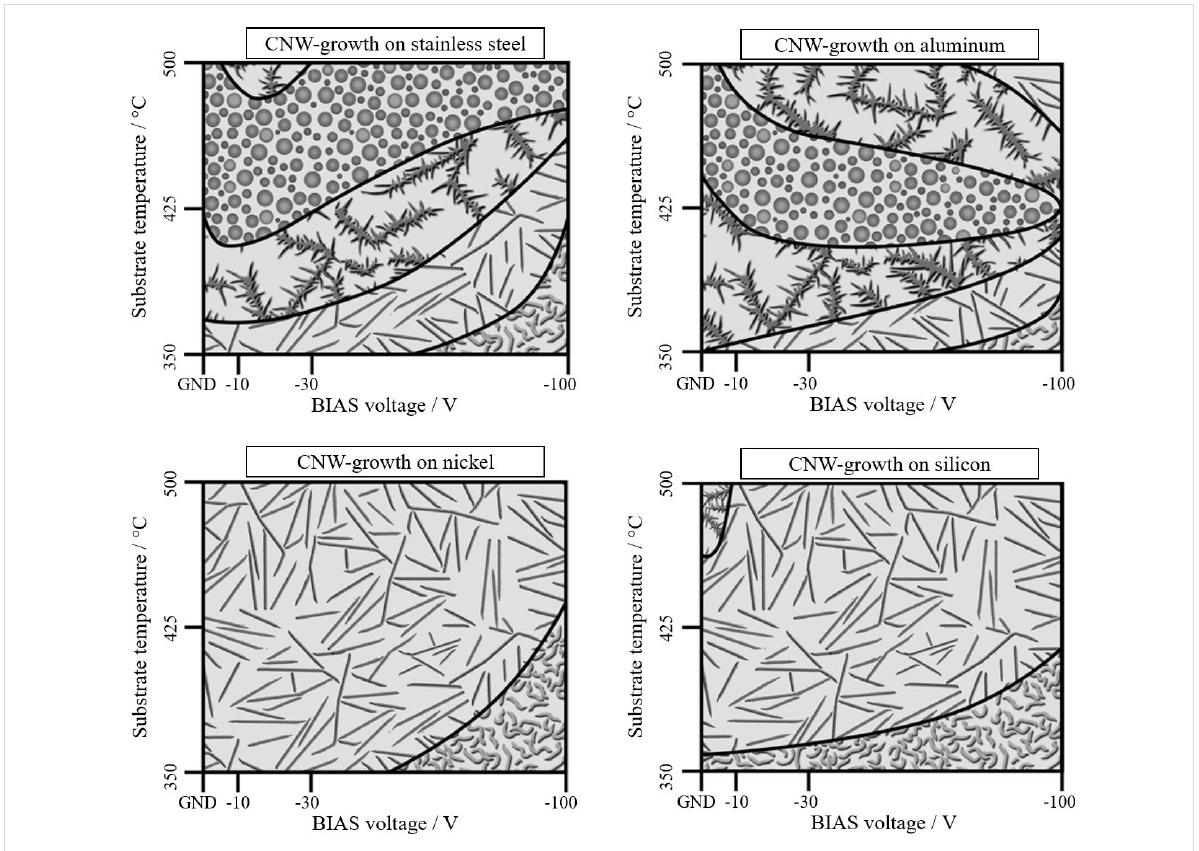
Figure 6: Growth zones on different substrate materials as a function of substrate temperature and bias